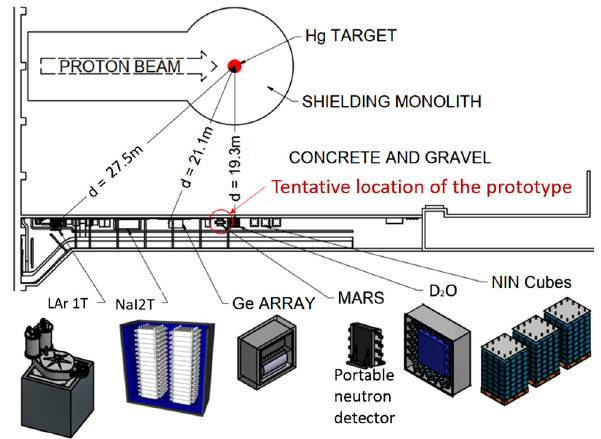
Fig. 15 Possible location of the proposed detector in the Neutrino Alley at the